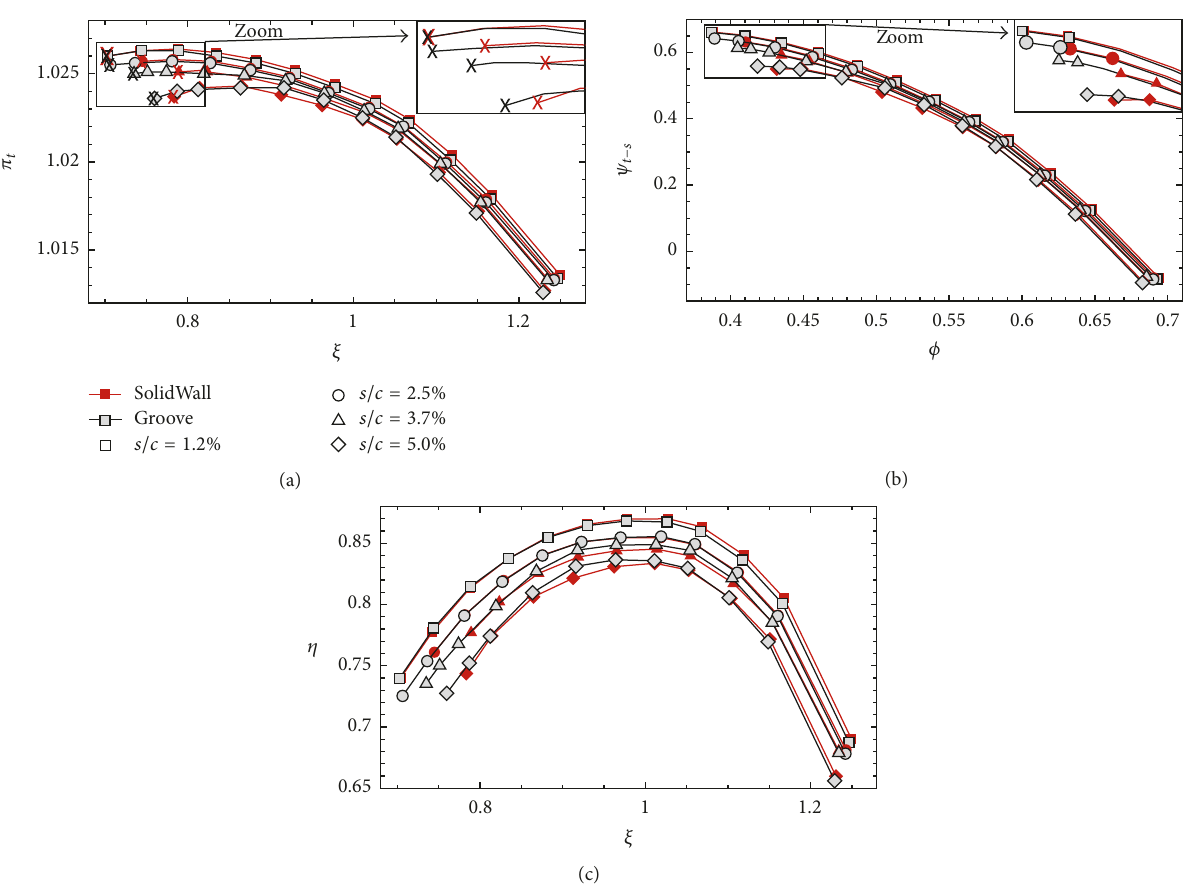
Figure 4: Compressor characteristics: (a) total pressure ratio, (b) total-to-static pressure coefficient, and (c) efficiency.